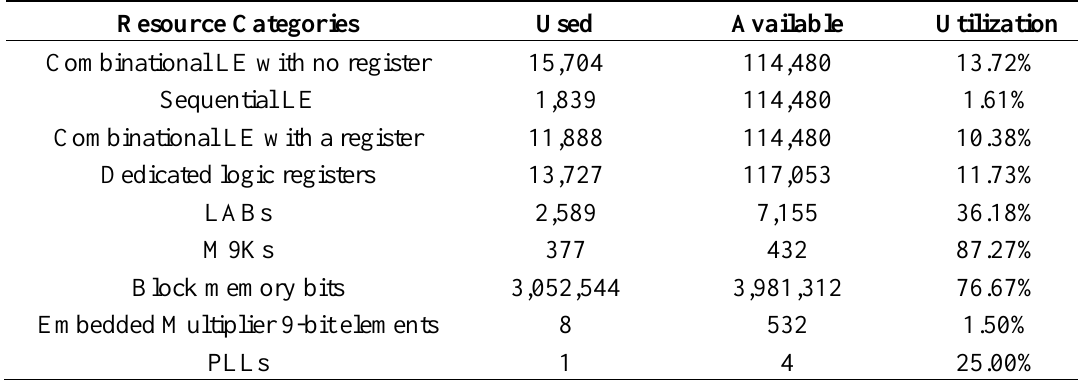
Table 4. FPGA implementation resource consumption.